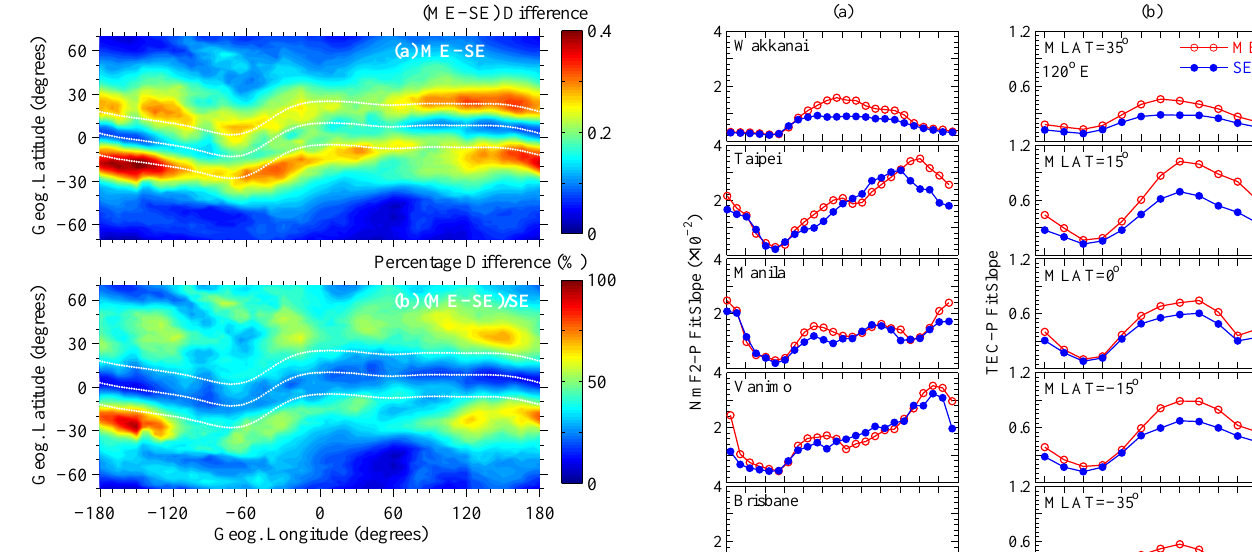
Fig. 6. Same as Fig. 5 but for the distributions of (a) the (ME-SE) difference and (b) the percentage difference of the linear fit slope of TEC with P .